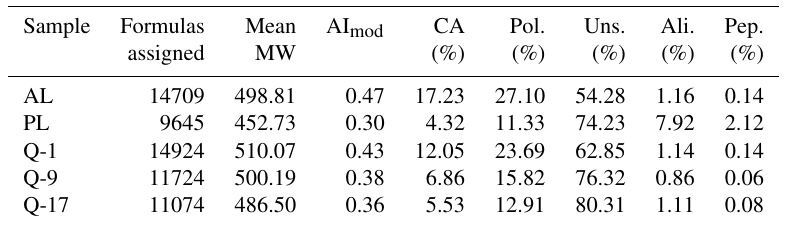
Figure 4. Variations of 14 C age of HMW UDOM across the alpine stream spatially (a) , and at headstream Q-1 temporally (b) . Table 1. The number of molecular formulas assigned, modified aromaticity index (AI mod ), mean molecular weight (mean MW) and relative abundance of defined compound classes detected by FT-ICR MS for DOM samples from the QTP, including soil leachates (AL and PL) and stream waters (Q-1, Q-9 and Q-17). CA denotes condensed aromatics, Pol. denotes polyphenols, Uns. denotes highly unsaturated compounds, Ali. denotes aliphatic and Pep. denotes peptides. The molecule signatures of AL and PL leachate DOM can also be found in Wang et al.